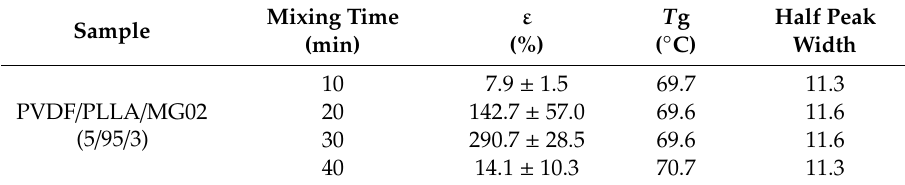
Table 2. Comparison table of DMA data and elongation at